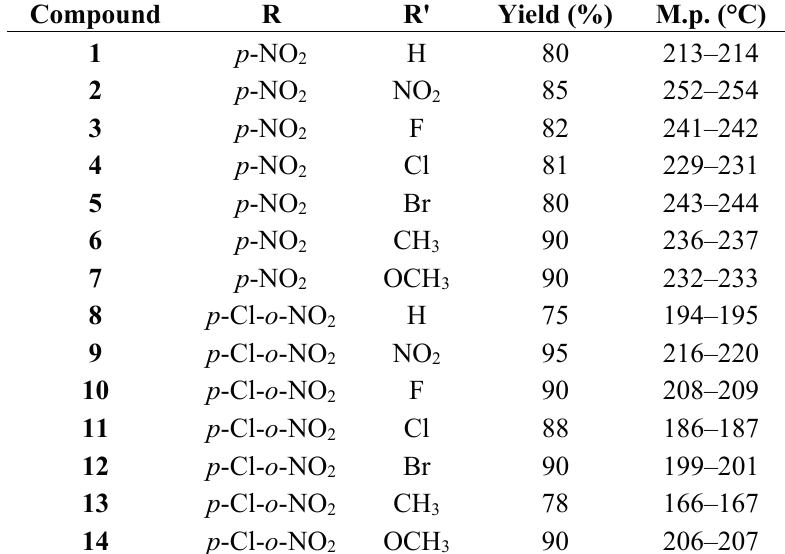
Table 1. The yields and melting points (M.p.) of thiazolyl hydrazone derivatives 1 – 14 .